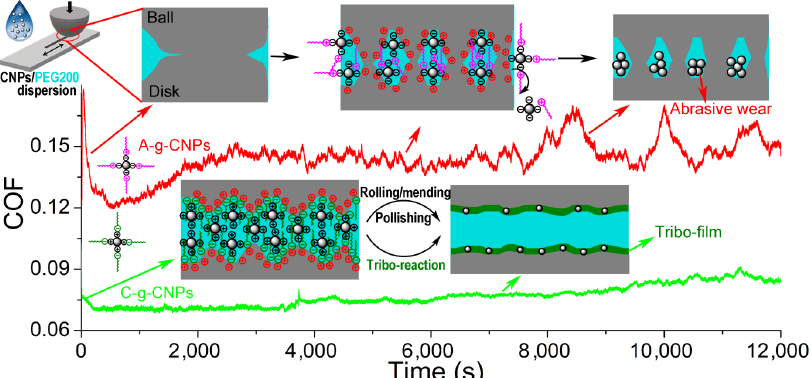
Fig. 17 Schematic plots of the lubrication mechanisms of A-g-CNPs and C-g-CNPs as additives of PEG200 (0.7 wt%) under the conditions of 100 N and 200